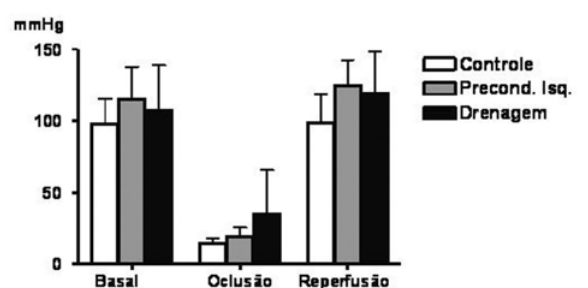
Fig. 2 - Pressão arterial sistêmica média distal, antes, durante e após a oclusão da aorta, nos três grupos. Os valores estão expressos em média e